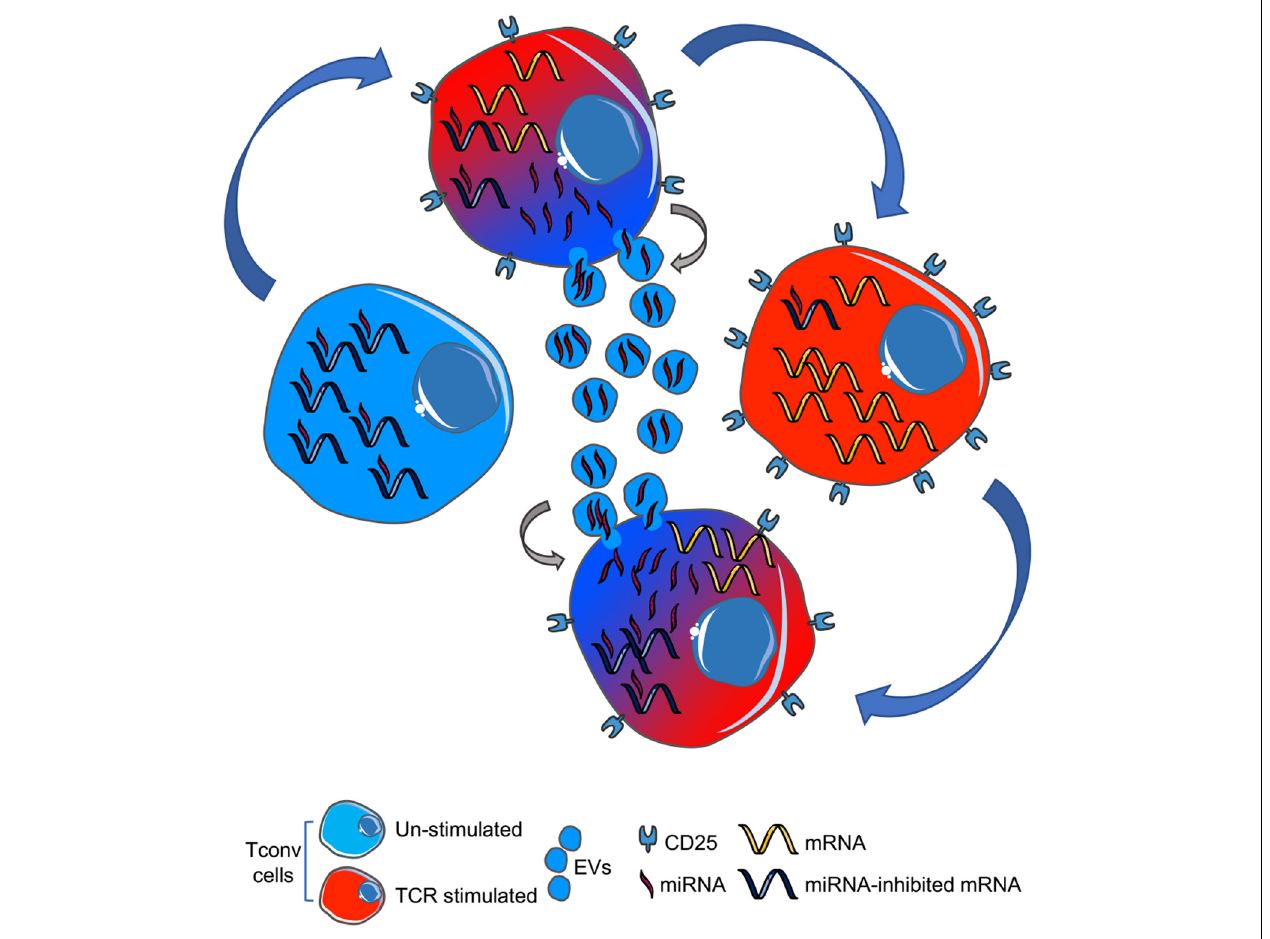
FIGURE 2 | Cartoon summarizing our hypothesis: upon TCR stimulation, a naïve T cell (blue, left) downregulates miRNAs (also) by EV-associated release into the extracellular space (blue to red gradient, upper), thus leading to proper mRNA expression in activated T cell (red, right). EV-miRNAs can be up-taken by an adjacent T cell (red to blue gradient, lower), thus causing mRNA repression and (partial) cell inhibition. TCR, T-cell receptor; EVs, extracellular